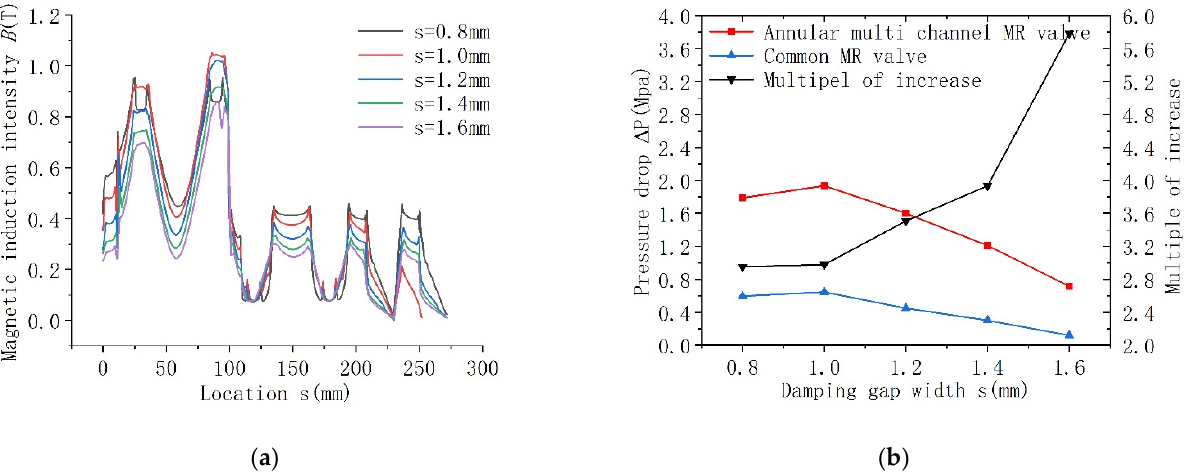
Figure 9. ( a ) Influence of damping clearance on magnetic flux density of annular multi-channel type; ( b ) influence of damping clearance on annular multi-channel pressure drop performance.